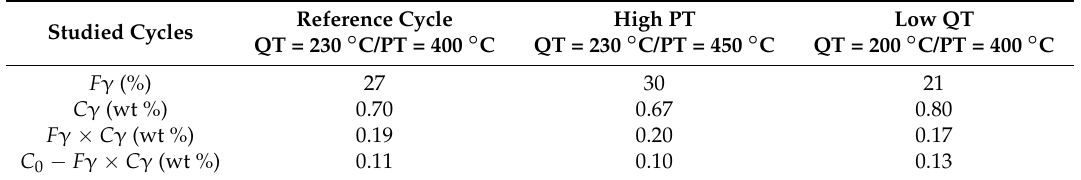
Table 2. Carbon mass balances in austenite and in the bcc phases at RT after studied cycles. The phase fractions were deduced from Figures 3 and 4. The carbon contents in austenite were measured using the relative change in the lattice parameter in step (iv) given in Table 1.